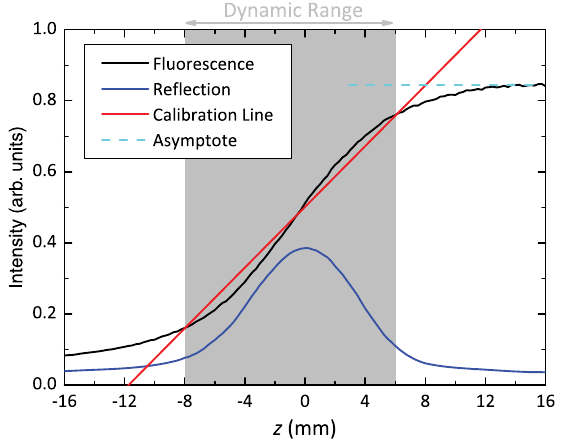
FIG. 10. A typical example of calibration data. The x axis represents the position of the focal plane. z > 0 means focal plane inside the liquid film and z < 0 means it inside the air film. Black curve: Fluorescence light intensity. Blue curve: Reflection intensity of laser light. Red line: Calibration which passes through the fluorescence data at z ¼ f − 8 ; 6 g μ m. Shaded area: Dynamic range. Dotted cyan line: Asymptote of the fluorescence at large z